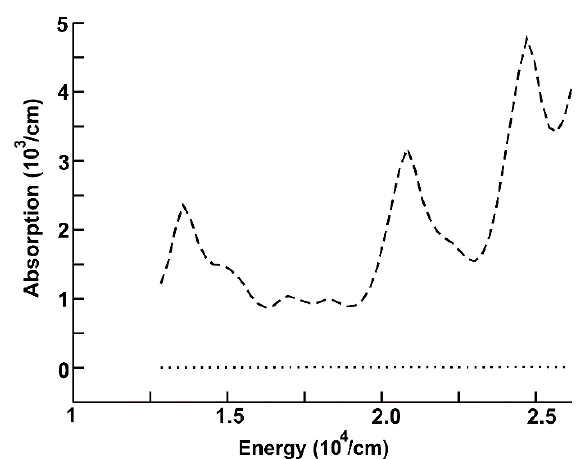
Figure 3. Absorption for the new system (dashed curve), and for graphene (dotted line) in the region of visible light.